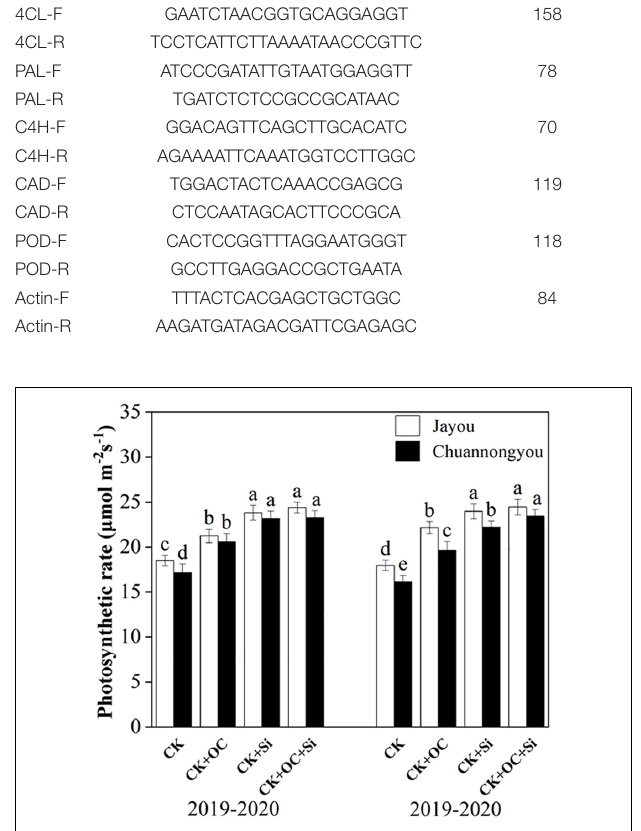
FIGURE 2 | Effect of organic carbon and silicon fertilizer on the photosynthetic rate of rapeseed leaves. Bars represent the means’ standard deviation ± (SD) ( n = 3). Different lower-case letters indicate significant differences among treatments at p ≤ 0.05 (LSD test). The CK, CK + OC, CK + Si, and CK + OC + Si represent the conventional fertilization, conventional + organic carbon fertilization, conventional + silicon fertilization treatment, and conventional + organic carbon + silicon fertilization